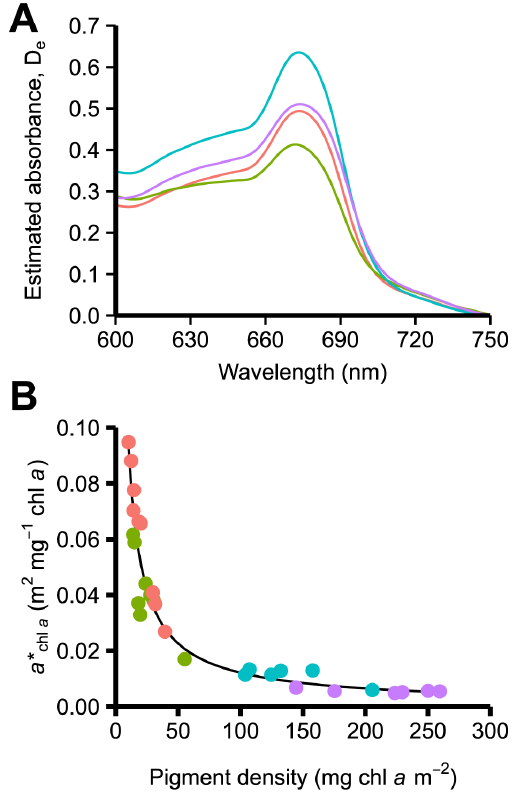
Figure 3. Estimated absorbance spectra, D e (A), and Chloro- phyll a specific absorption, a * chl a (B) in four Caribbean gorgonian species. Pterogorgia anceps (red line; n=9), Eunicea tourneforti (green line; n=8), Pseudoplexaura porosa (blue line; n=6), and Pseudoplexaura wagenaari (purple line; n=6). Lines in (A) represent average D e spectra for each species. The equation for the line in (B) is y=0.7586*(x 2 0.8976